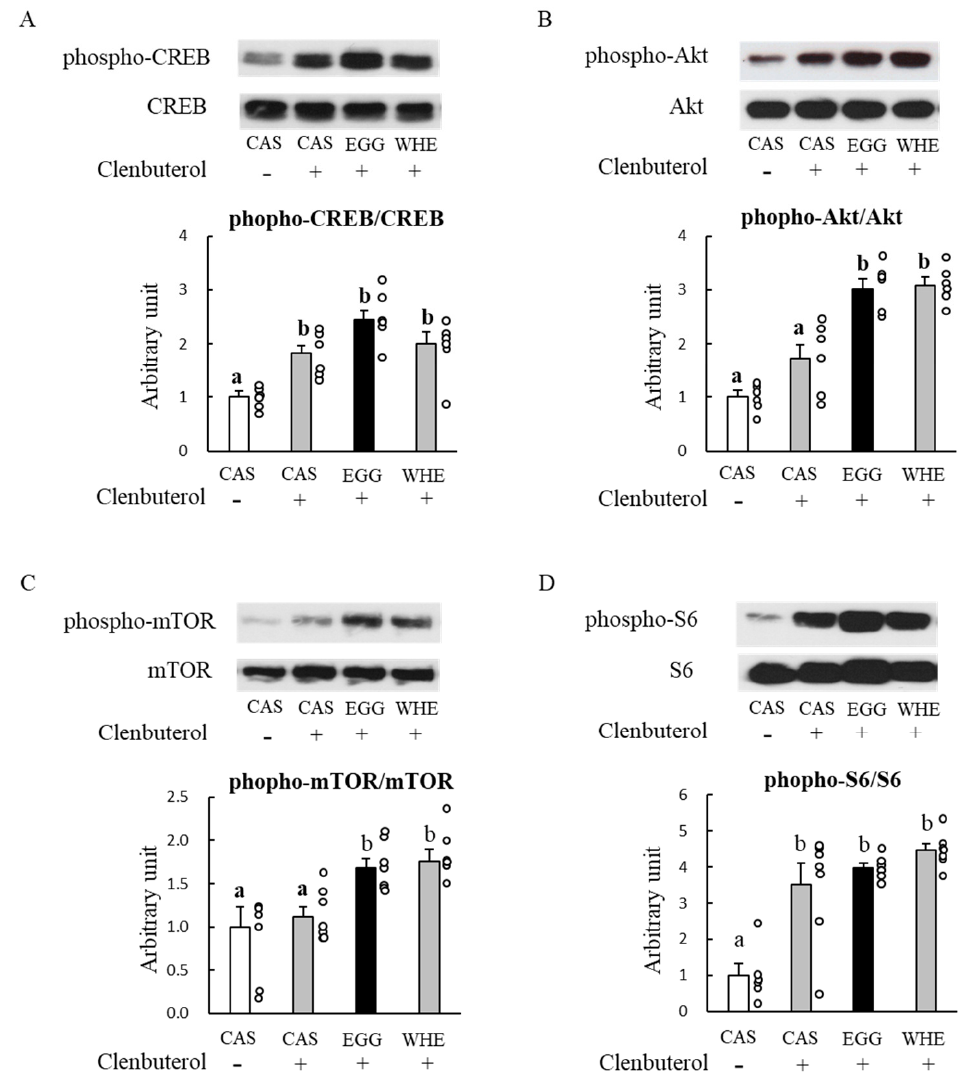
Figure 9. Acute effect of clenbuterol on muscle signal transduction (Day 3). Rats were assigned to either a casein, egg white, or whey protein diet group, and were maintained under ad libitum feeding for 2 days with/without saline or clenbuterol administration. On day 3, rats were administrated saline or clenbuterol. Two hours after the administration, plantaris muscles were dissected out for western blot analysis of CREB ( A ), Akt ( B ), mTOR ( C ), or S6 ( D ). The dots beside bars indicate individual value. Values are means ± SE ( n = 6–7). CAS: casein protein, EGG: egg white protein, WHE: whey protein. Different superscript represents statistical differences among